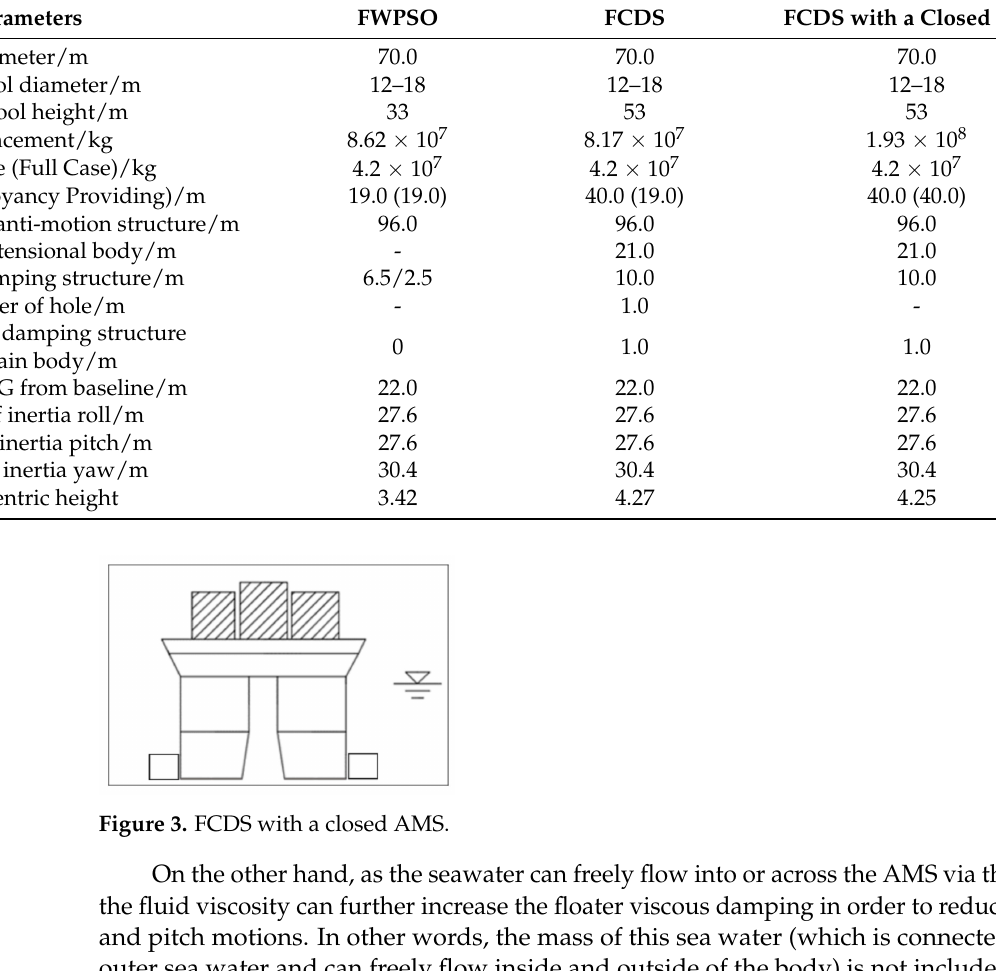
Table 1. Main dimensions of the FWPSO and FCDS.